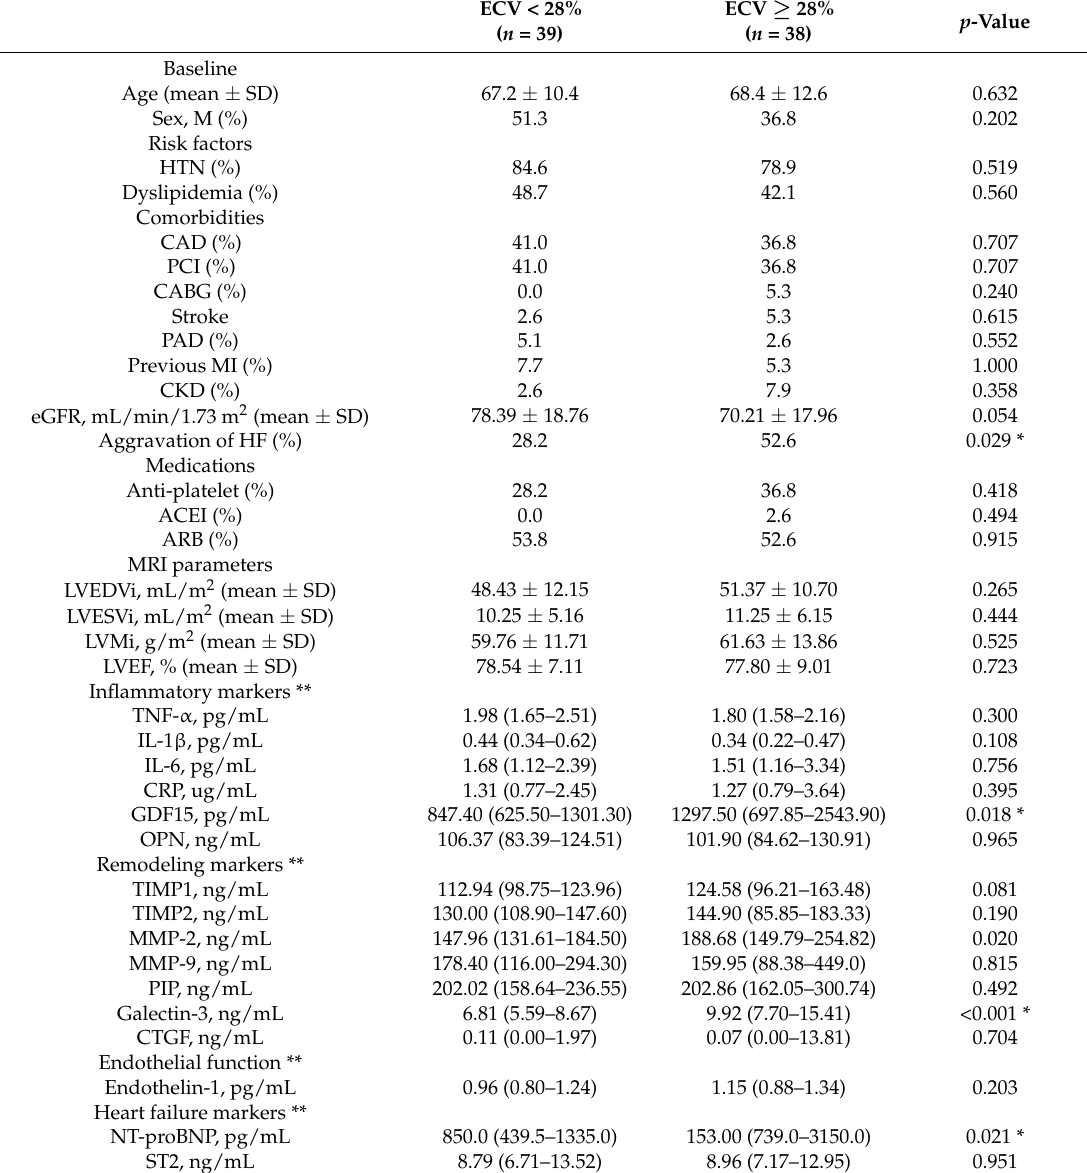
Table 1. Comparison of basic characteristics, risk factors, comorbidities, medications, and serum biomarkers between patients with low and high ECV in the study